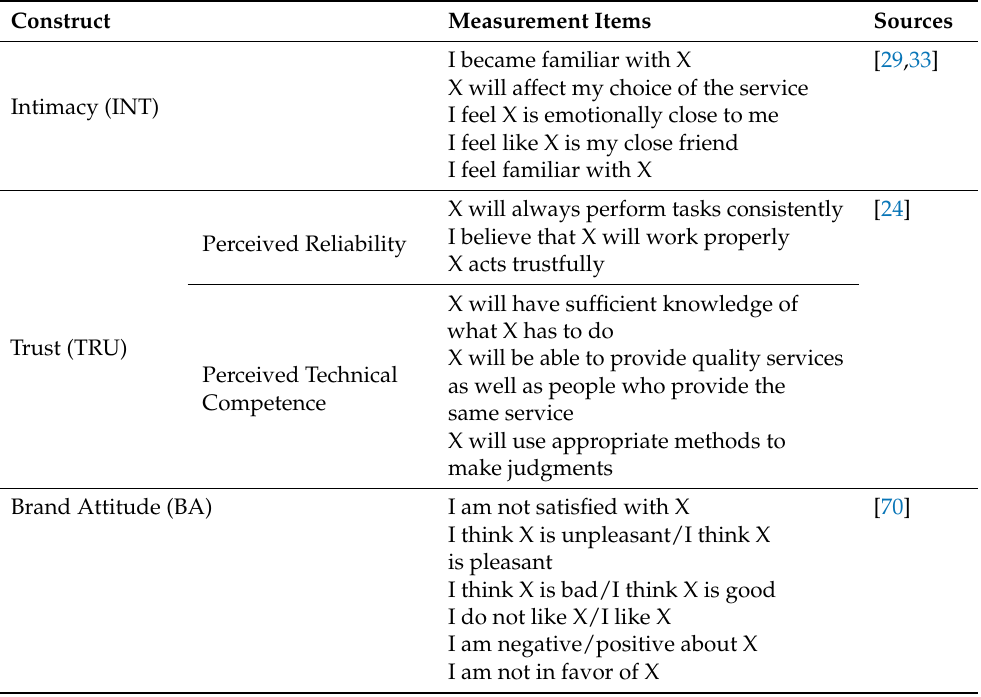
Table 4. Constructs and measurement items (X refers to the service